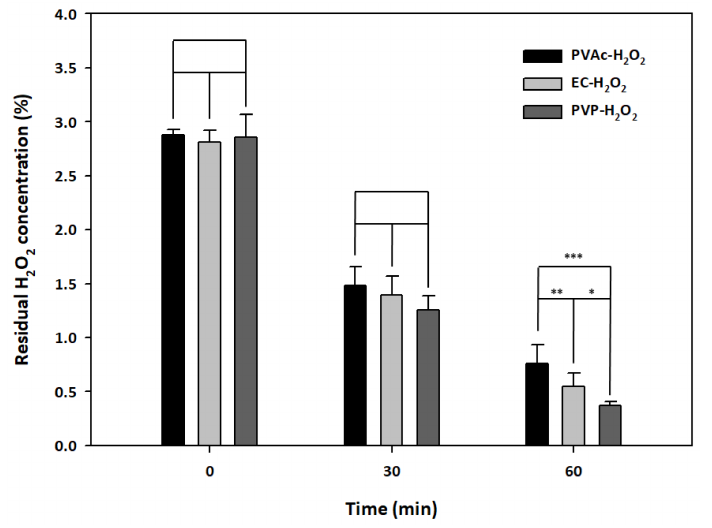
Figure 6. Residual H 2 O 2 concentration of PVAc-H 2 O 2 , EC-H 2 O 2 and PVP-H 2 O 2 tooth whitening compositions. (significant codes; *: p < 0.05, **: p < 0.01, ***: p <